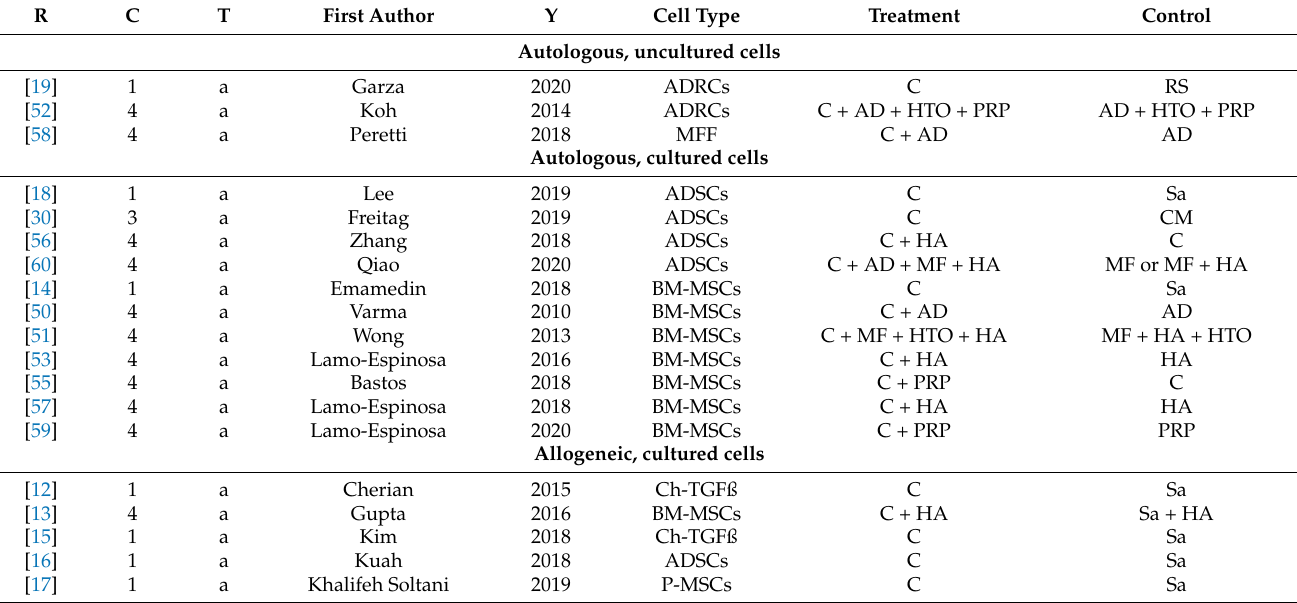
General abbreviations: R, reference number; C, category of study as outlined in Table 6; T, type of study as outlined in Table 6; and Y, year of publication. Abbreviations of cell types (in alphabetical order): ADRCs, adipose-derived regenerative cells; ADSCs, adipose-derived stem cells; BM-MSCs, bone-marrow-derived mesenchymal stromal cells; Ch-TGFß, chondrocytes that overexpress transcription growth factor beta; MFF, micro-fragmented fat; P-MSCs, placental MSCs. Abbreviations of treatments (in alphabetical order): AD, arthroscopic debridement; C, cells; HTO, high tibial osteotomy; MF, microfracture; RS, Ringer solution; PRP, platelet rich plasma; and Sa, saline.